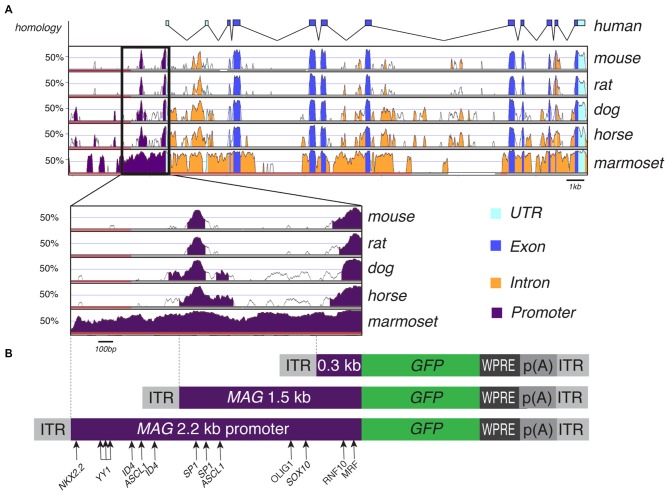
Myelin Associated Glycoprotein (MAG) promoter inter-species alignment and AAV expression cassettes. (A) VISTA plot of human sequence across the MAG locus and its genomic conservation in mouse, rat, dog, horse and marmoset. A close-up of the 2.2 kb upstream promoter region shows two regions of high conservation, suggestive of functional importance, from −118 to −1 bp and from −1315 to −1176 bp upstream the putative transcription start site. (B) AAV expression cassettes for GFP reporter expression controlled by the 0.3 kb, 1.5 and 2.2 kb human MAG promoter. Transcription factor binding sites with relevance to oligodendroglial gene expression are indicated.